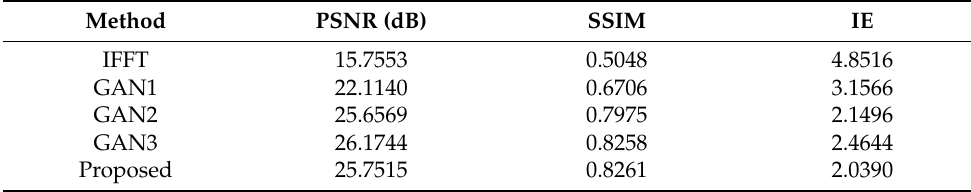
Table 7. Numerical performance evaluation for simulated aircraft under sparse